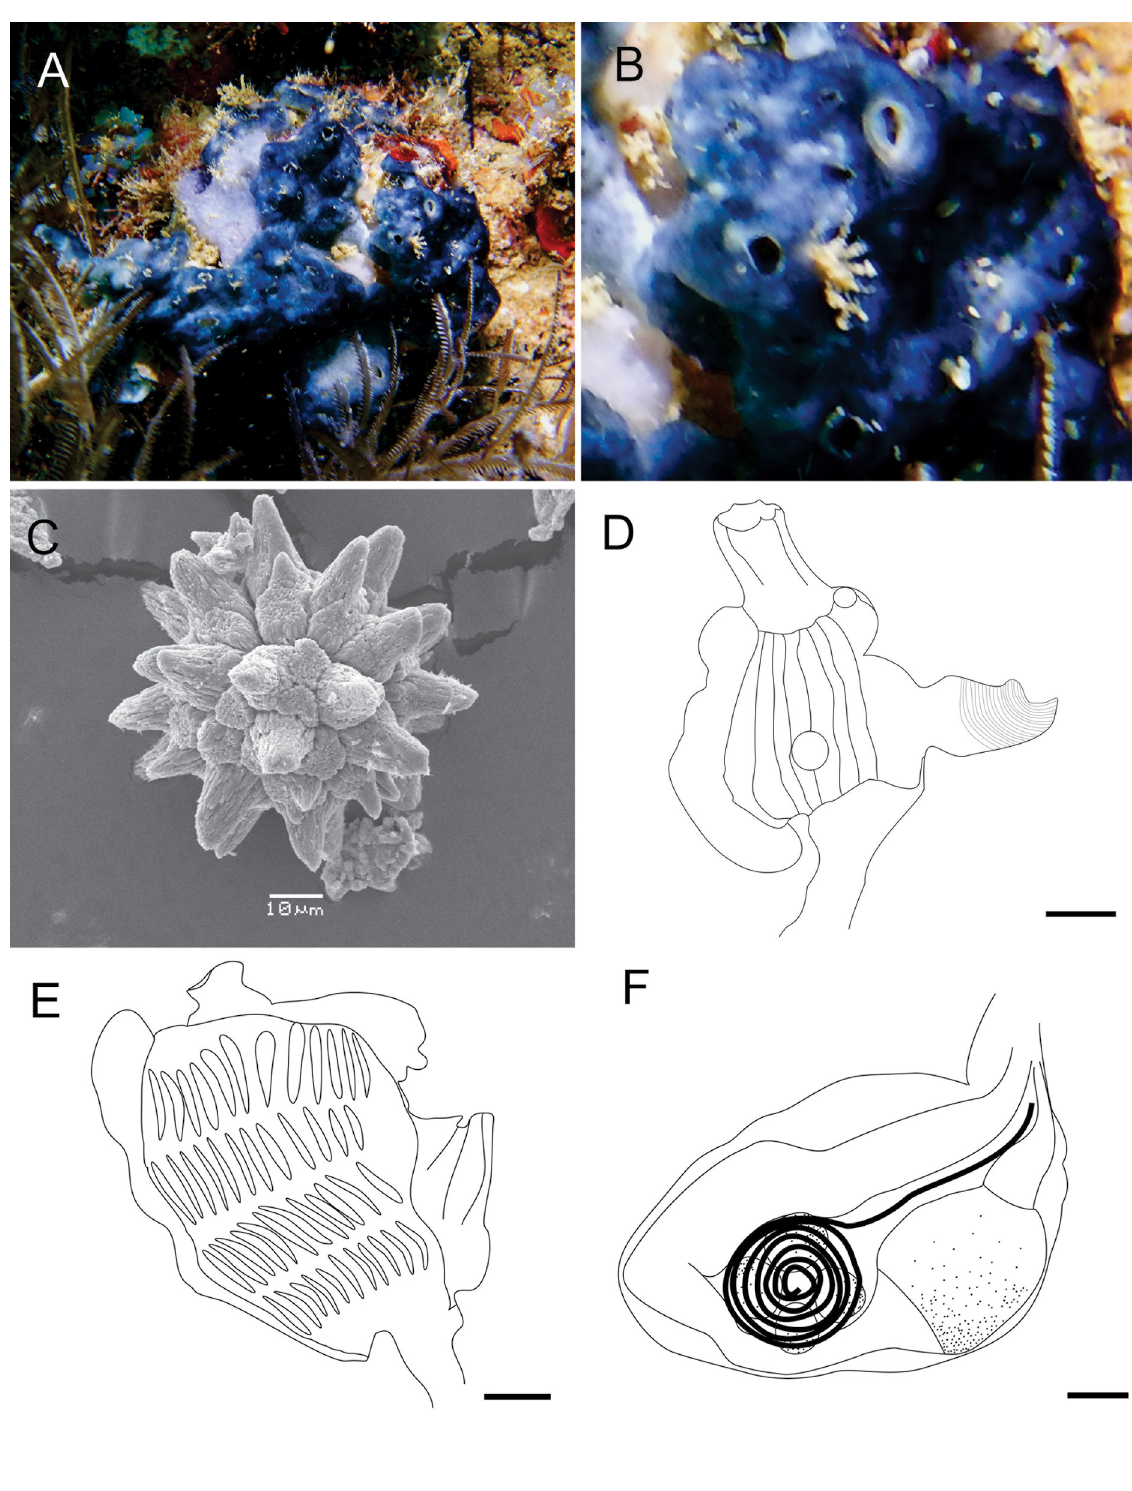
Fig. 4. Leptoclinides torosus F. Monniot, 1983. A . Colony in situ . B . Detail of the surface of the colony (DZUP LEP-017). C . Spicule. D–E . Thorax. Atrial siphon inadvertently removed during dissection in E. F . Abdomen (DZUP DID-171). Scale bars: D–F = 0.1